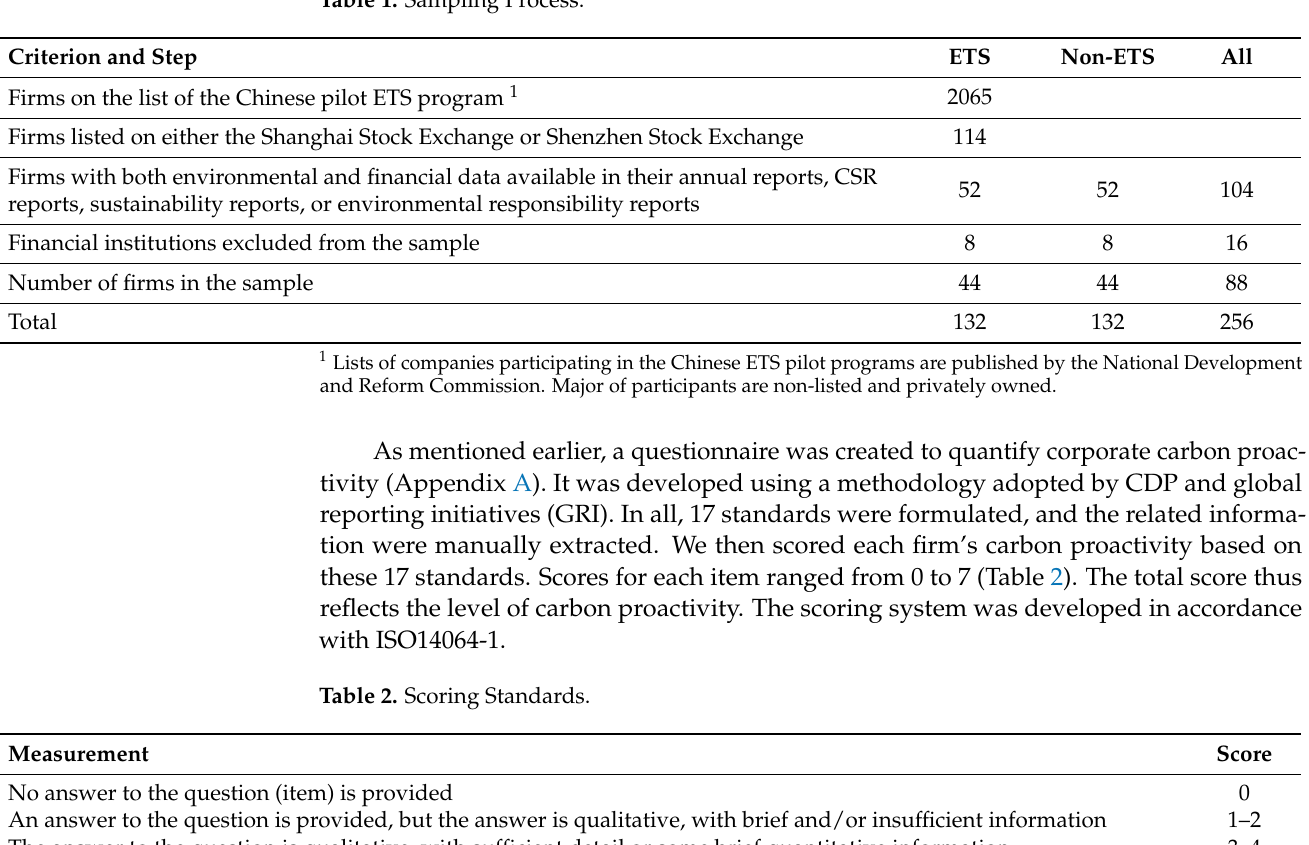
Table 1. Sampling Process.